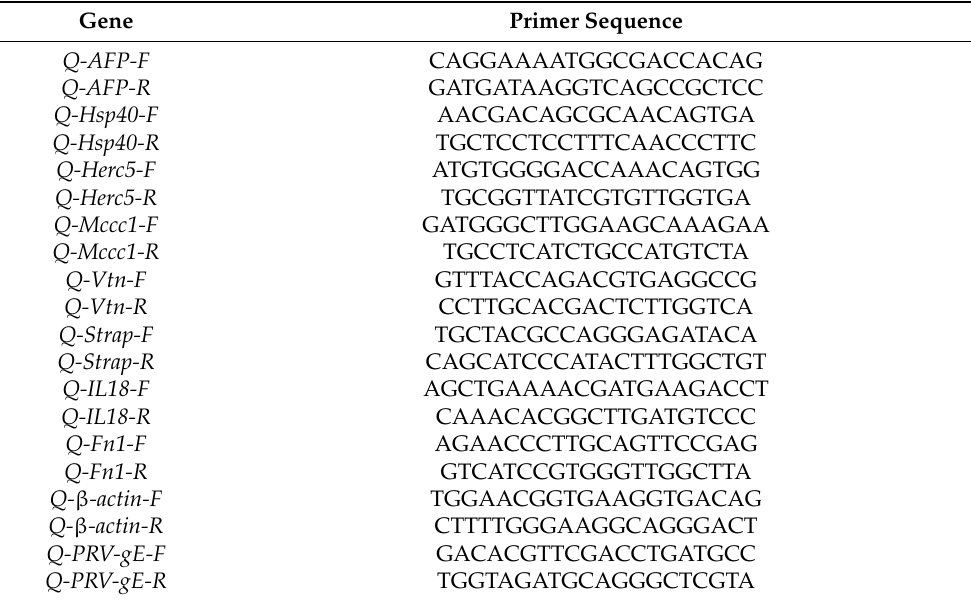
Table 1. Primers of the selected differentially expressed